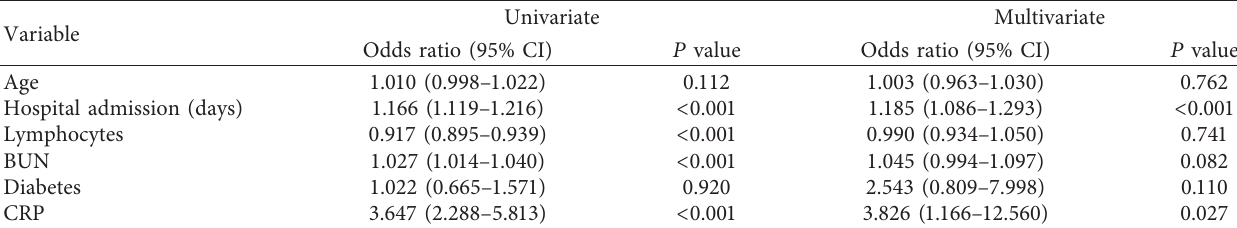
Table 4: Univariate and multivariate analyses of the logistic regression